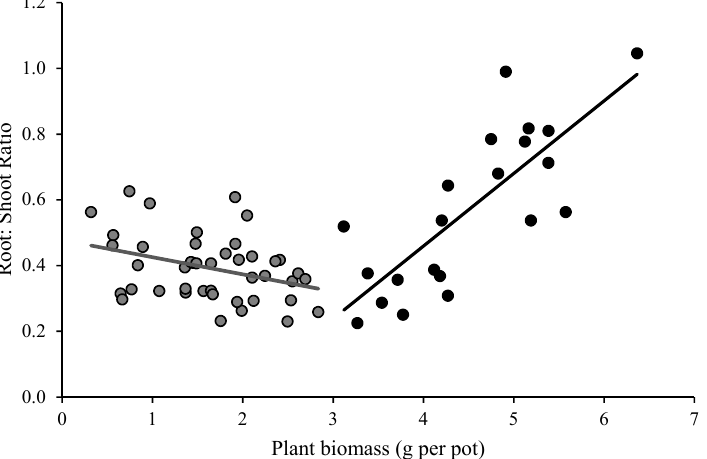
Figure 2. Pearson correlation between plant biomass and root:shoot ratio. The complete data (64 units) had r = 0.54, p = 2.9 × 10 − 6 . Small plants with biomass lower than 3 g (42 units) had r = − 0.32, p = 0.02. Large plants with biomass exceeding 3 g (22 units) had r = 0.79, p = 2.1 × 10 − 5 .